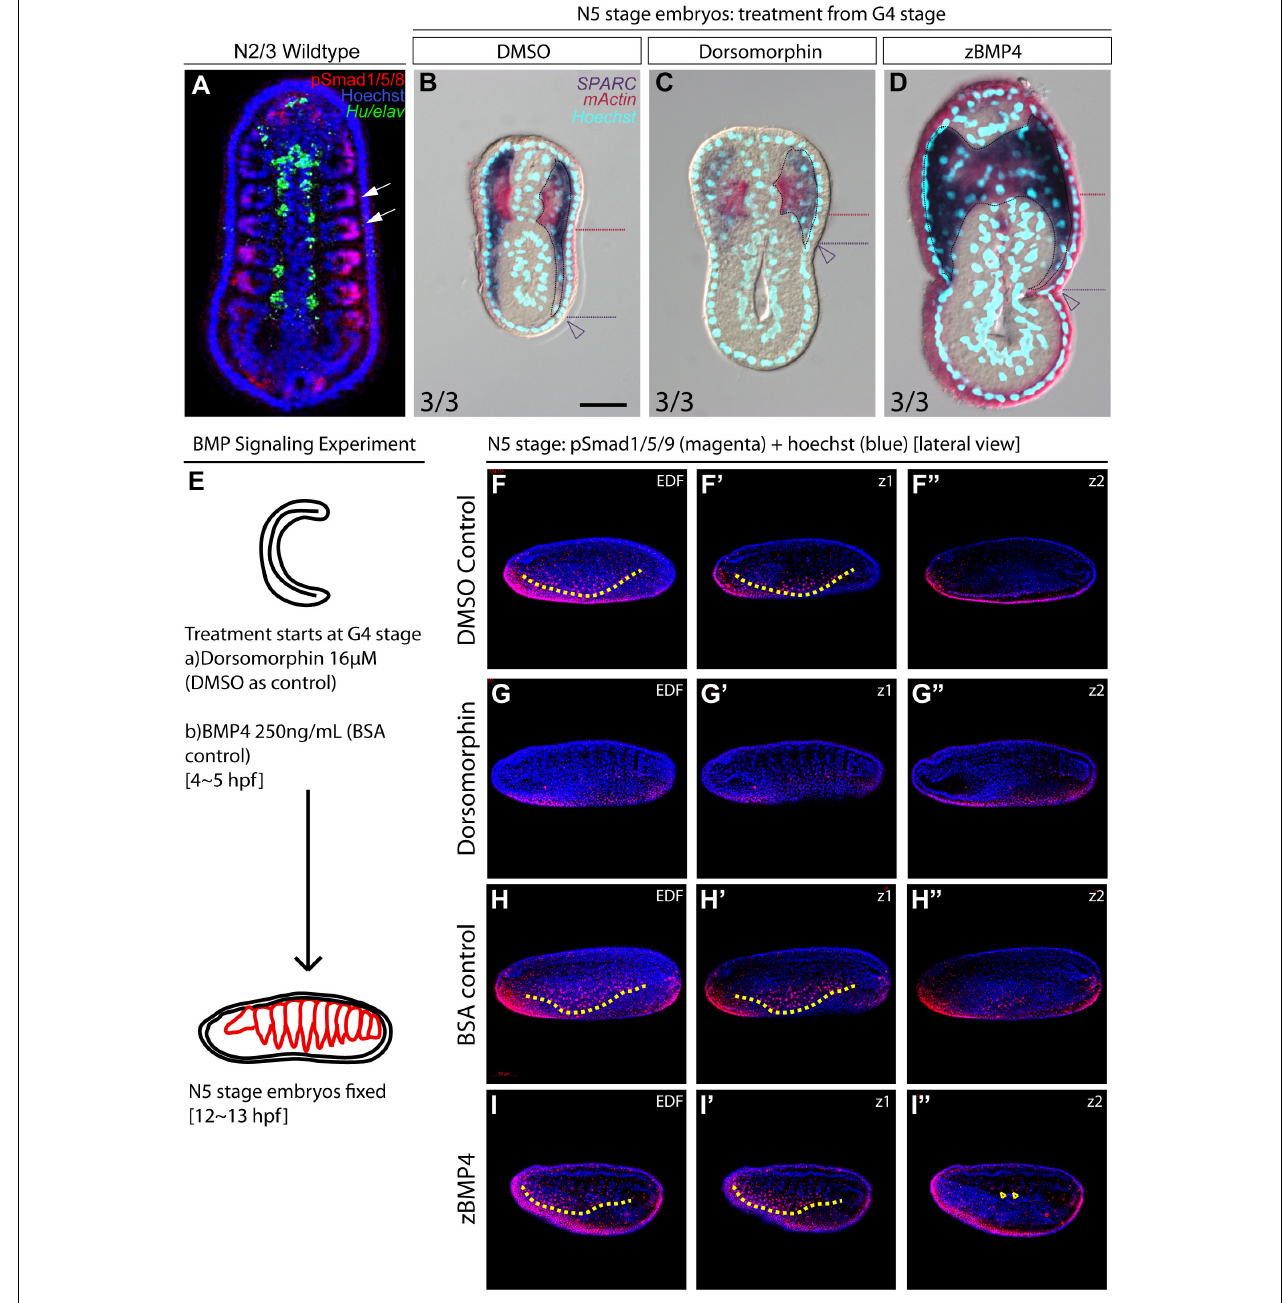
FIGURE 5 | Medial-lateral patterning of amphioxus somites is controlled by the level of BMP signaling. (A) Dorsal view of a stage N2/3 embryo. Anterior is to the top. Nuclear signals of pSmad1/5/8 are present preferentially in the lateral part of the somites (white arrows). Hu/elav (green) label indicates the midline structure in the embryo. (B–D) Cross sections of N5 embryos treated with BMP signaling inhibitor Dorsomorphin or recombinant zBMP4 protein at G4 stage. Scale bar, 25 µ m. Red dotted lines mark the ventral boundary of the myotome region. Purple dotted lines mark the ventral boundary of the lateral somite region. Numbers on bottom left: denominator represents the total number of embryos that sectioned at 4 ∼ 6th somite level, numerator shows the number of embryos which show the displayed phenotype when sectioned. DMSO control is used as the count number for the control column. BSA whole mount embryos are shown in Supplementary Figure 4 . (B) Double in situ hybridization showing the expression domain of SPARC and mActin in a control embryo treated with DMSO. (C) Section of N5 embryo treated with 16 µ M dorsomorphin. (D) Section of N5 embryo treated with 250 ng/ml of zBMP4 protein. (B–D) Whole mount embryo of cross section in panels (B–D) is shown in Supplementary Figure 4 . (E) Treatment time and concentration of BMP Signaling experiment. (F–I (cid:48)(cid:48) ) pSmad1/5/9 staining of embryos after BMP Signaling perturbation. Lateral view. Yellow dotted lines demarcate the ventral limit of the pSmad1/5/9 nuclear signal in the ventrally expanding somite. EDF, Extended Depth of Focus. Z1 demarcates the z-level which that corresponds to the EDF view. Z2 demarcates the z-level that is approximate at the notochordal level. (I (cid:48)(cid:48) ) Yellow arrowheads point to positive pSmad1/5/9 nuclear signal which roughly corresponds to the region where lateral gene markers are ectopically disorganized.